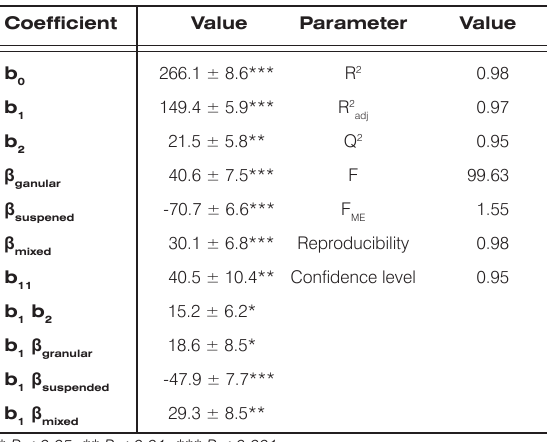
correlation and significance of the model are shown in the last two